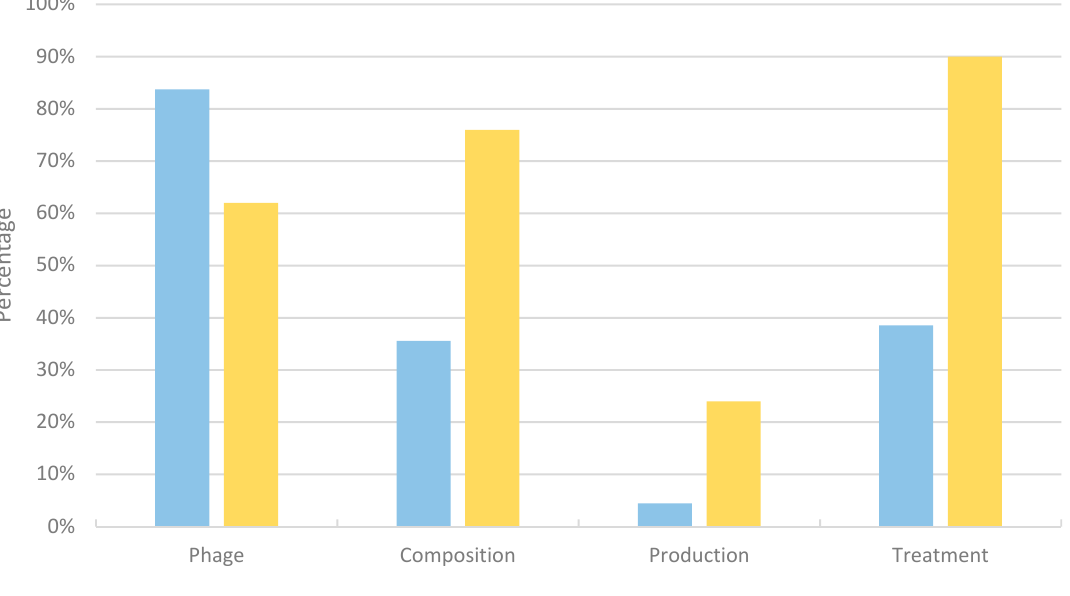
Figure 4. Claim and abstract analysis of the active, granted patents and scientific publications. In total, 79 independent claims from 21 patents and 137 abstracts from scientific papers were categorized among four different categories: (1) Phage—here the phage was described as the active ingredient or the isolation of a phage was described, (2) Cocktail—this category contains claims that protect the combination of phages and publications that describe a phage cocktail, (3) Production—ways of how the phage is produced, and (4) Treatment—claims that protect the use of phages to fight a specific bacterial infection or methods and application strategies for using the phage (e.g., bioassays, field trials). In blue, the percentages of publications are shown; in yellow, the percentage of claims are shown. Note: one publication and patent can be categorized in multiple categories.